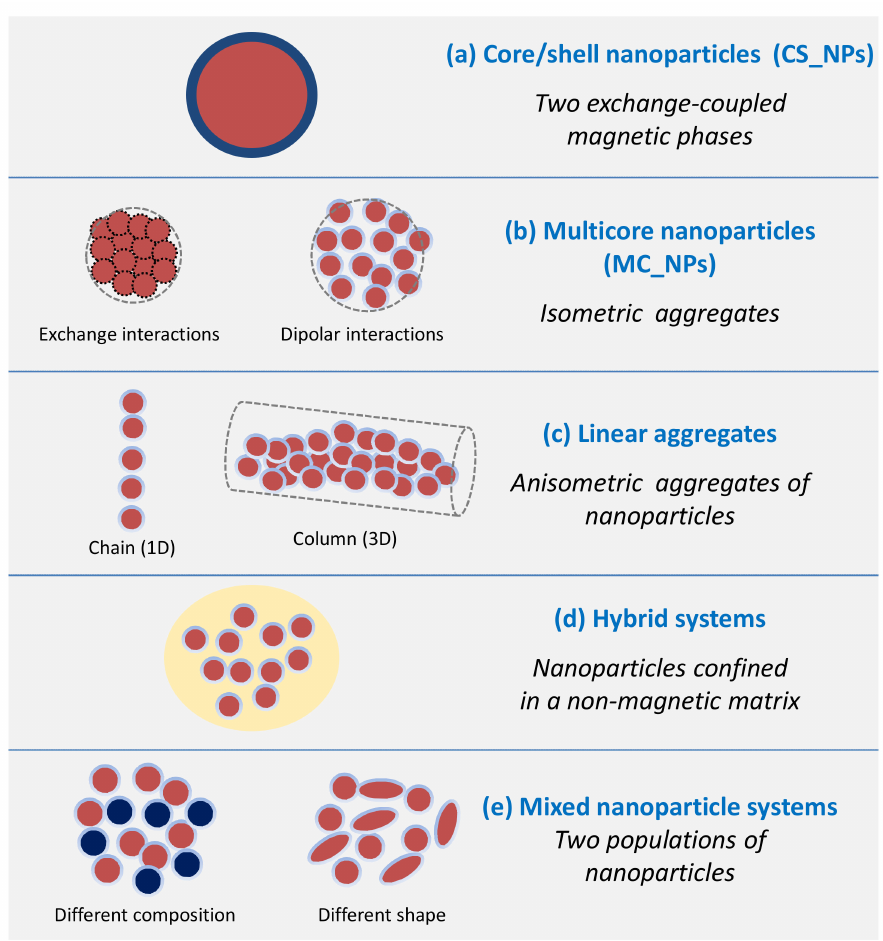
Figure 1. Scheme showing the different classes of magnetic NP systems whose magnetic heating performance is determined by the synergy between two or more constituent magnetic